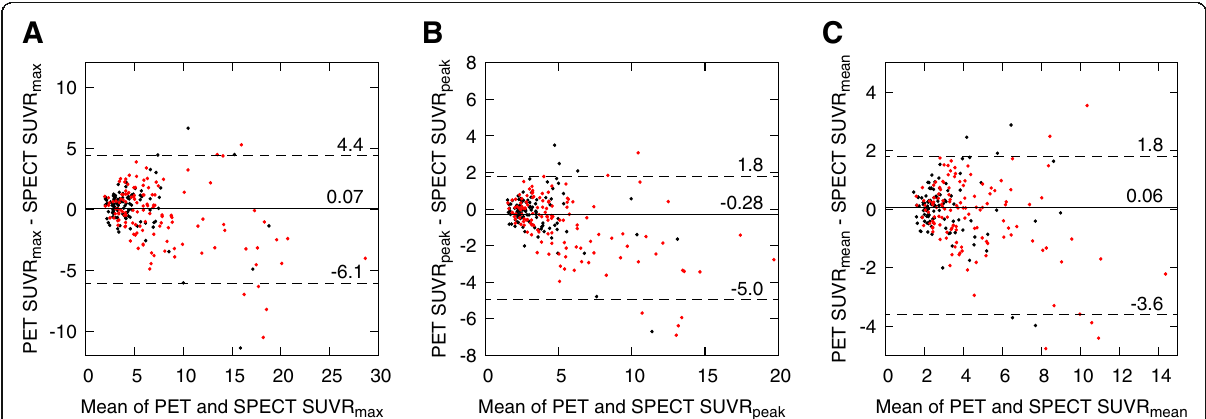
Fig. 5 Bland-Altman plots of a SUVR max , b SUVR peak , and c SUVR mean from SPECT and PET data for all lesions. The x -axis represents the mean of SPECT and PET SUVRs and the y -axis the difference between SPECT and PET SUVRs. Metastatic lesions are marked in red and benign in black. Solid lines with numerical values denote median differences and dotted lines with values denote 95%